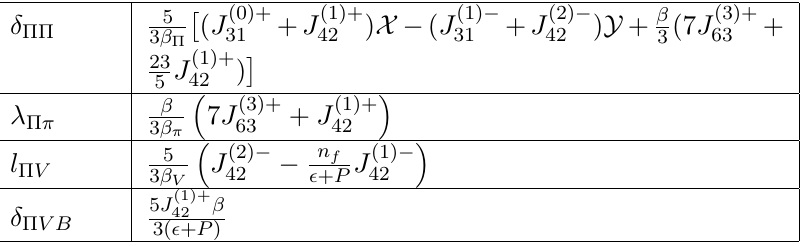
Table 3 . Transport coefficients appearing in bulk equation eq. (3.23).